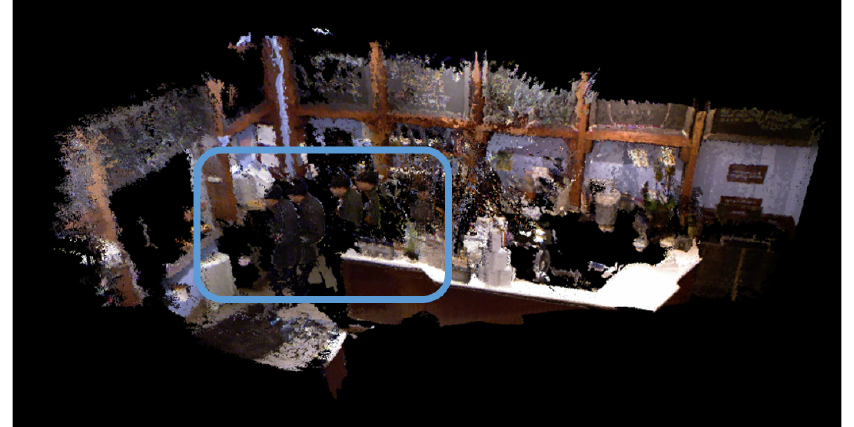
Figure 2. Dense point cloud map constructed by keyframe-based SLAM. We can find that pedestrians in the scene also appear in the map, which will bring many difficulties to the application of the map, such as path